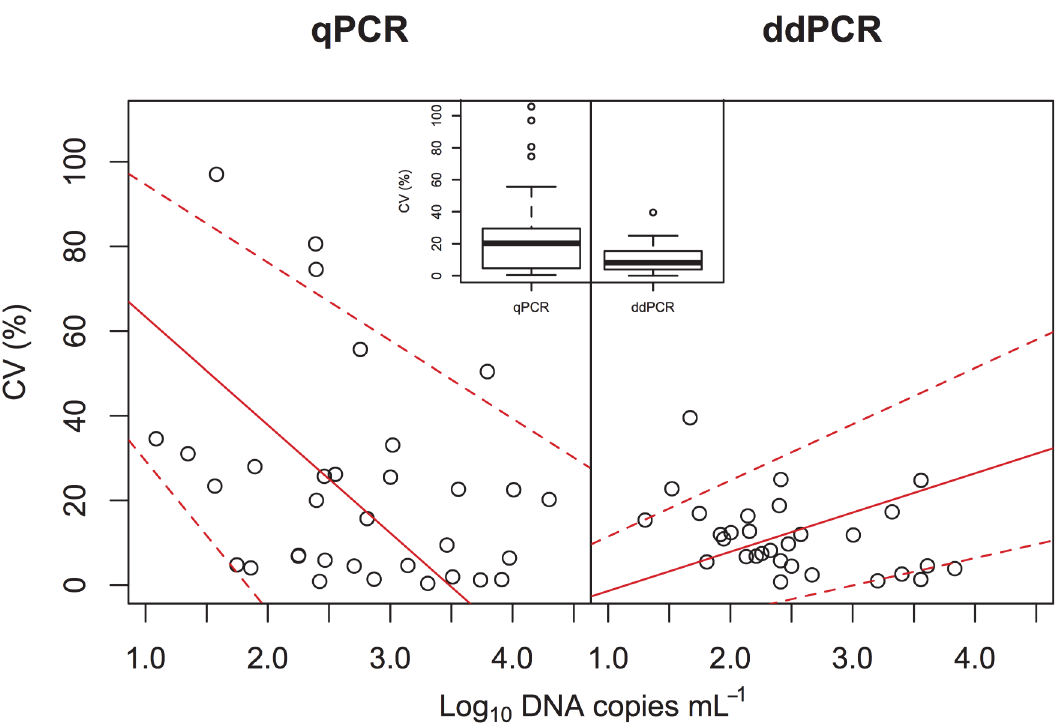
Fig 2. Relationships between eDNA concentrations of common carp and coefficients of variation (CV, %) measured using qPCR and ddPCR. Solid red and dashed red lines indicate Type II regression and 95% CI, respectively. Boxes in the box plot indicate median ± quartiles, and points indicate the outliers. The means of CVs were significantly different by Welch ’ s t-test (t = – 2.98, p =